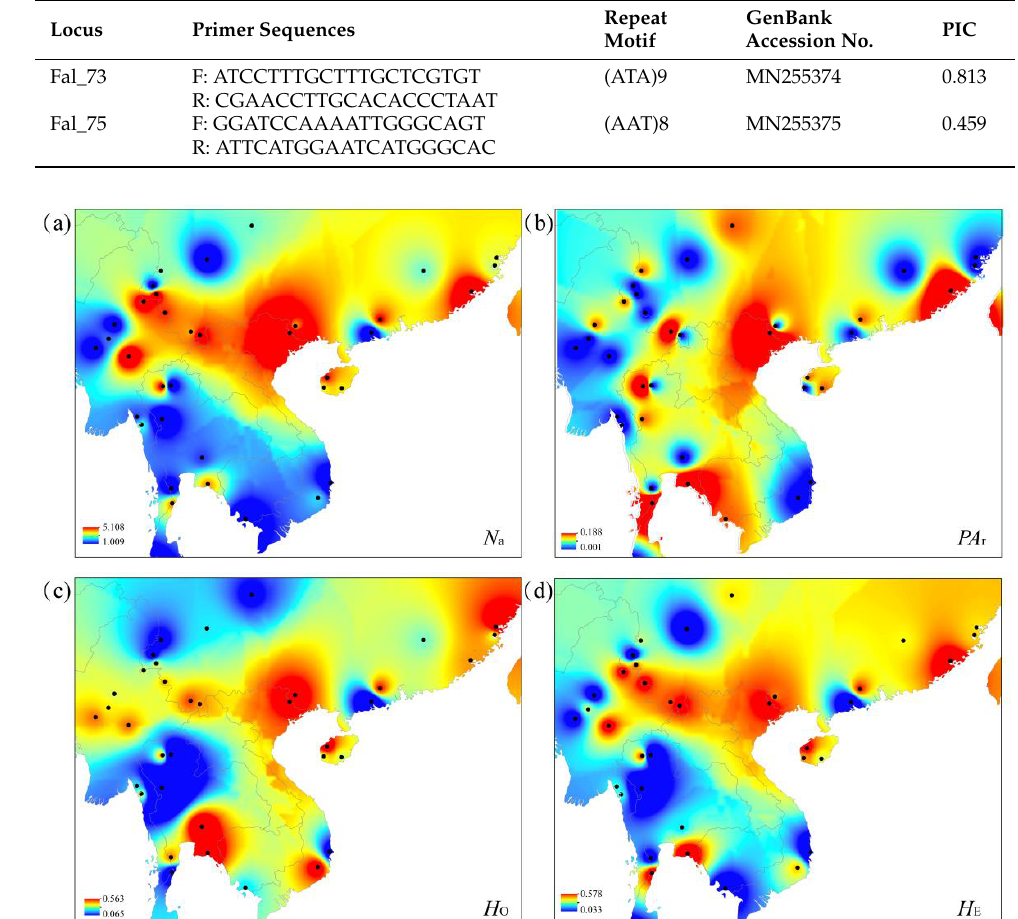
Figure 2. Genetic diversity maps of the 37 F. altissima populations (black dots) in Indo-Burma and adjacent southern China: ( a ) IDW interpolation of the mean number of alleles per locus ( N a ); ( b ) IDW interpolation of the mean number of private alleles per locus ( PA r ); ( c ) IDW interpolation of the observed heterozygosity ( H O ); ( d ) IDW interpolation of the expected heterozygosity ( H E